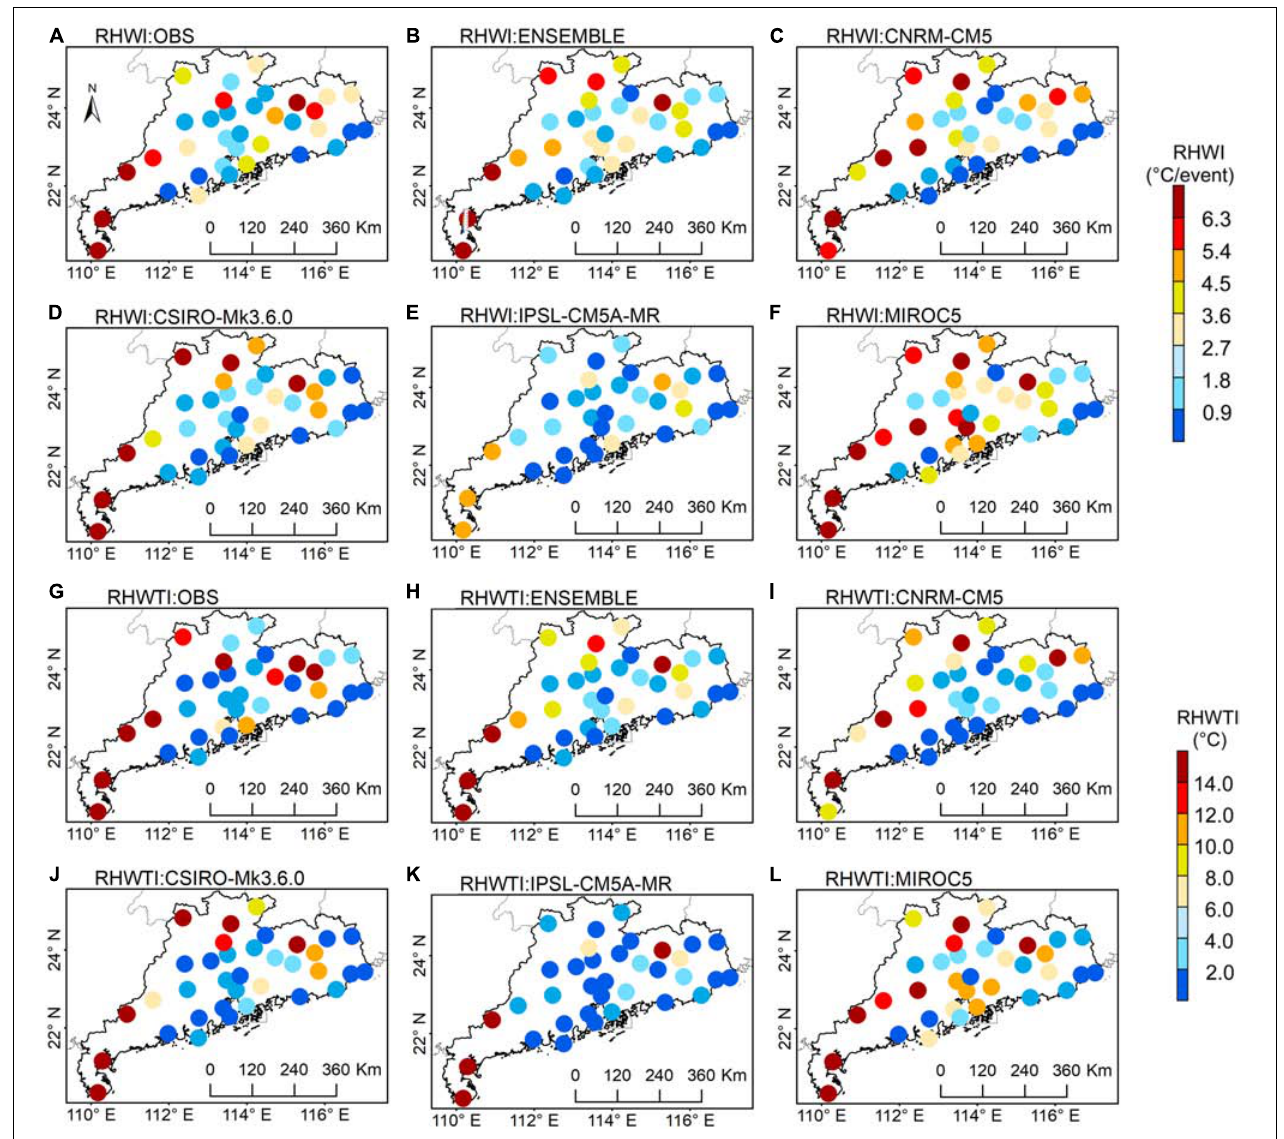
FIGURE 10 | The spatial distributions of observed (A) and simulated RHWI (unit: ◦ C/event), driven by CNRM-CM5 (C) , CRIRO-Mk3.6.0 (D) , IPSL-CM5A-MR (E) , and MIROC5 (F) and the model ensemble (B) . Panels (G–L) are same as panels (A–F) , but for RHWTI (unit: ◦